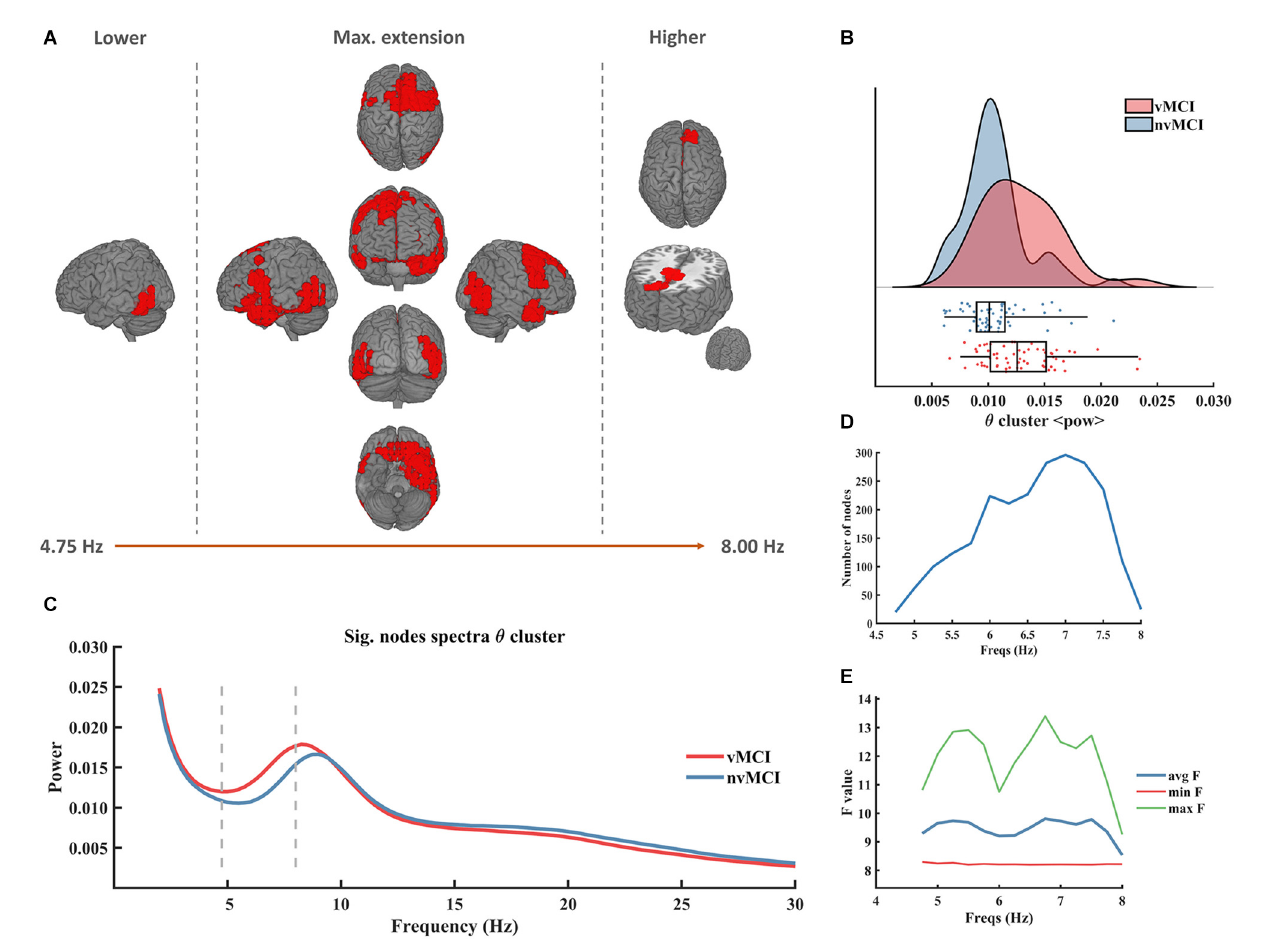
FIGURE1 Significant result found within the theta frequency range. (A) Description of the regions involved in the θ cluster. The cluster was found to be significant between 4.75 Hz and 8.00 Hz. In the figure can be seen the initial, final, and maximum extensions of the cluster. (B) Violin plots and boxplots graphics describing the individual values for the average power of the cluster in the significant frequency range. (C) Representation of the average spectral power across all significant nodes. The significant frequency region is marked with dashes lines. (D) Number of grid nodes that are part of the cluster at each frequency step (maximum extension was found at 7 Hz). (E) Minimum, maximum, and average F values across all nodes contained within the cluster at each frequency